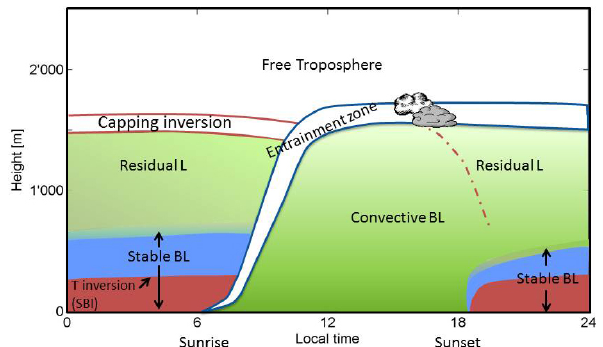
Figure 1. Diurnal cycle of the PBL height over land for a clear convective day (adapted from Stull,